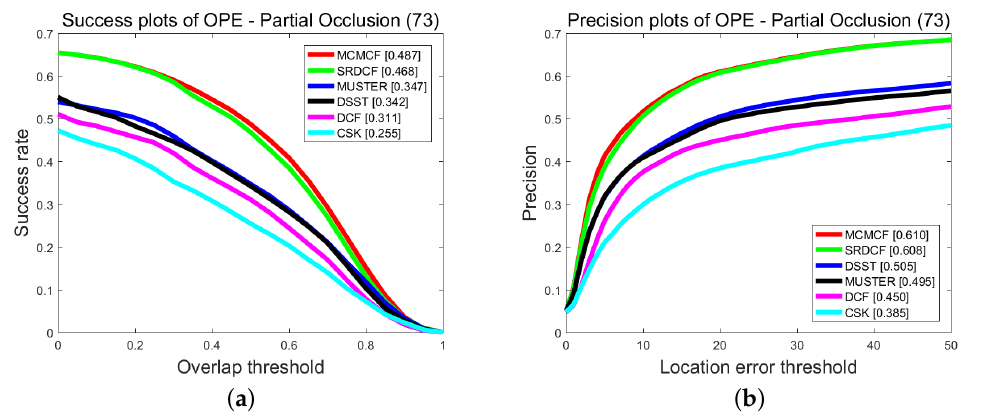
Figure 8. Comparison of success rate and accuracy with the same type of tracker on a dataset based on partial occlusion in UAV123: ( a ) success result for models; ( b ) precision result for